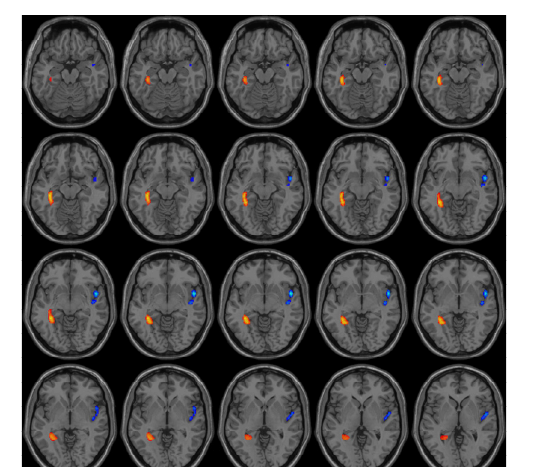
The CKD4 group was found to have decreased CBF in the right insula and increased CBF in the left hippocampus compared to the HC group (Figure 2).